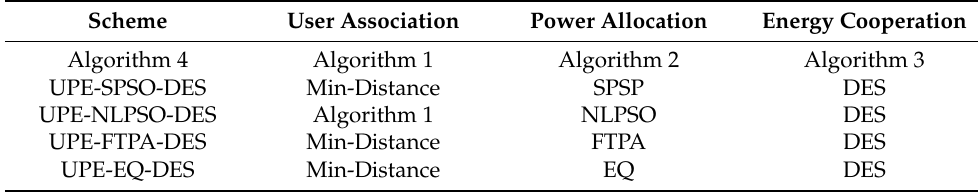
16 of 23 Table 2. System parameters. Parameter